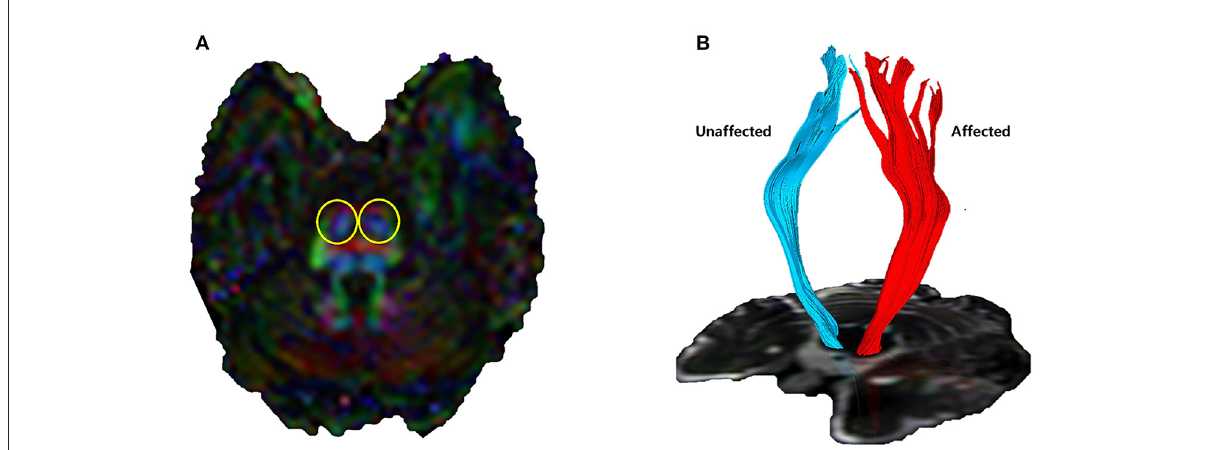
FIGURE1 Corticospinal tract (CST) visualized by diffusion tensor tractography. (A) Lower anterior pons (yellow circles) and primary motor cortex were designated as regions of interest. (B) 3D reconstructed CST by fiber assignment by continuous tracking algorithm. Quantitative indicators such as the number of fiber tracts, fractional anisotropy (FA), and axial diffusivity (AD) can be